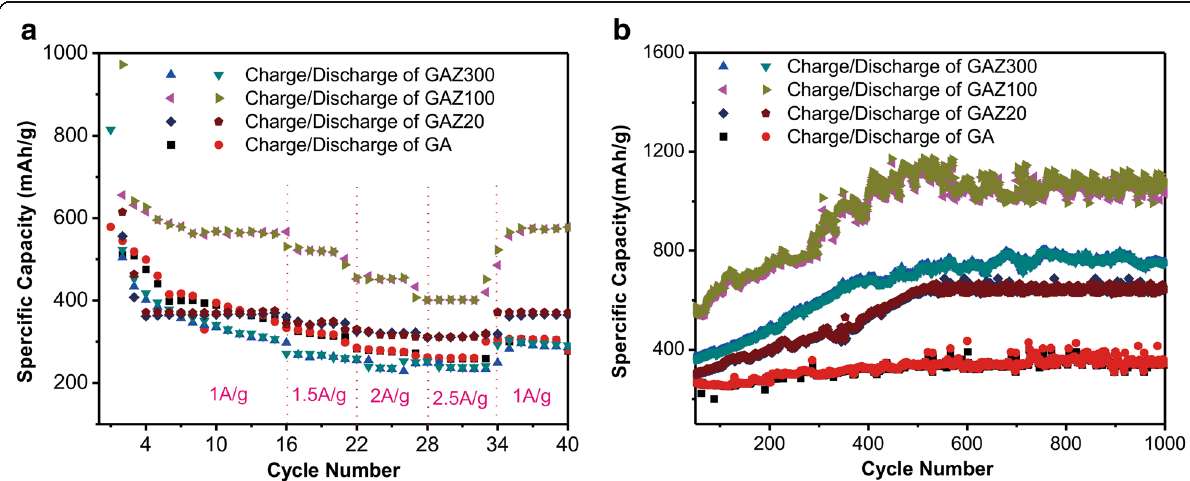
Fig. 3 a Rate performance of pure GA and GAZ composite with different ALD cycles. b Cycle performance of pure GA and GAZ composite with different ALD cycles. A high current density of 1000 mA g − 1 was used in the